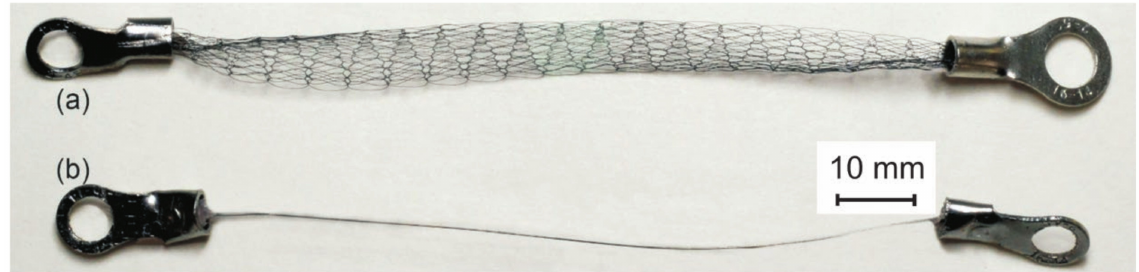
Figure 1. ( a ) NiTi knitted mesh and ( b ) NiTi superelastic wire.